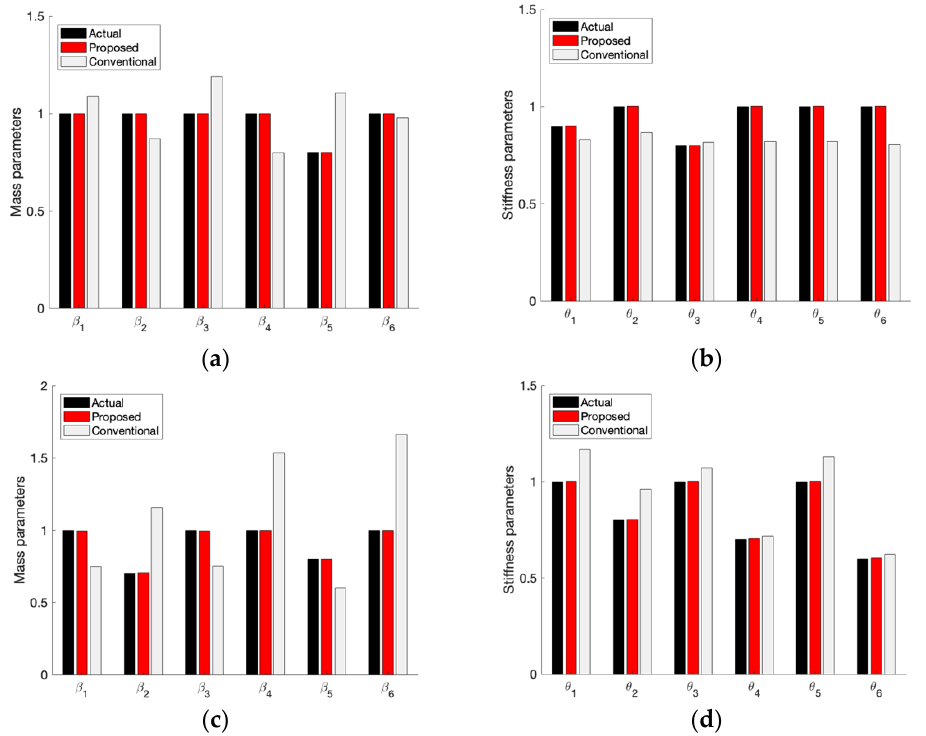
Figure 6. Updated parameters by two approaches. Damage case No. 1: ( a ) mass; ( b ) stiffness. Damage case No. 2: ( c ) mass; ( d ) stiffness.